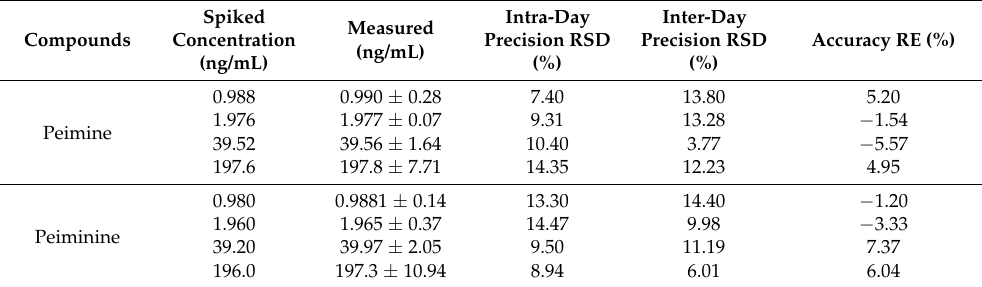
Table 3. Precision and accuracy of determination of peimine and peiminine in beagle plasma ( n = 18, six replicates per day for three